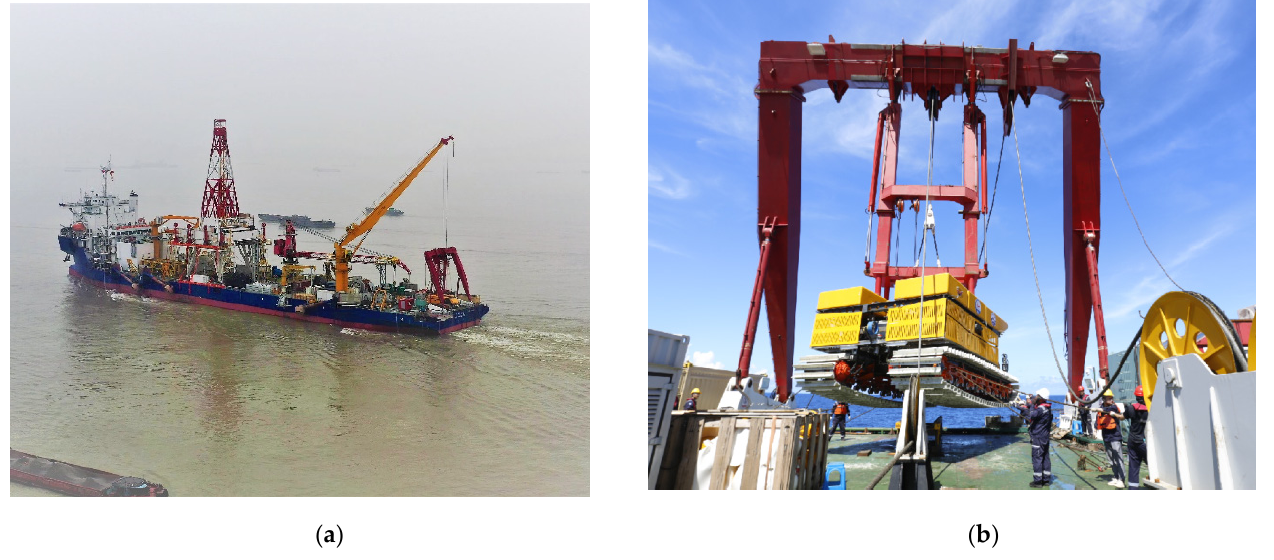
Figure 4. The photographs of the mining test. ( a ) The mining test ship; ( b ) the test collector.